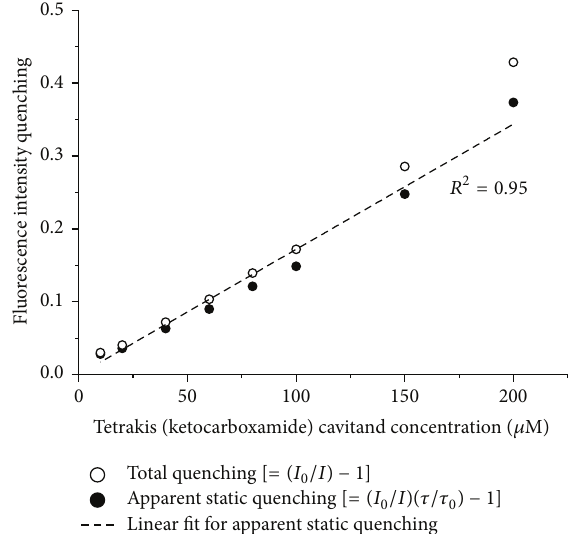
Figure 6: Stern-Volmer plot for the total and for the apparent static quenching of anthracene by 1 .